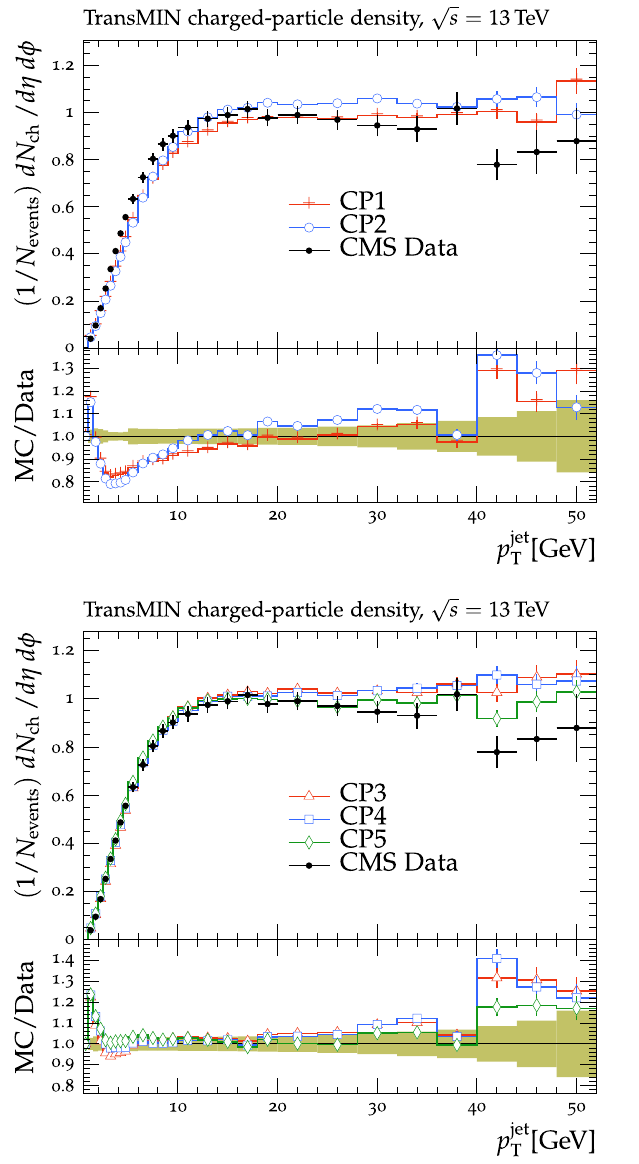
Fig. 14 The transMIN charged-particle multiplicity (left column) and (MC/Data) is also shown, where the shaded band indicates the total p T sum densities (right column) for particles with p T > 0 . 5GeV in experimental uncertainty in the data. Vertical lines drawn on the data | η | < 2 . 0 as a function of the transverse momentum of the leading points refer to the total uncertainty in the data. Vertical lines drawn √ on the MC points refer to the statistical uncertainty in the predictions. s = 13TeV analysis [16]. charged-particle jet, p jet , from the CMS T Horizontal bars indicate the associated bin The upper-row plots show the LO tunes, while the lower-row plots show the higher-order tunes. The ratio of the simulations to the data